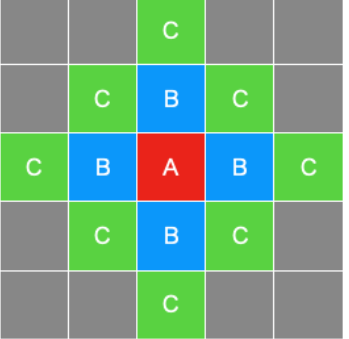
Figure 6. The positional relationship of neighboring zones.